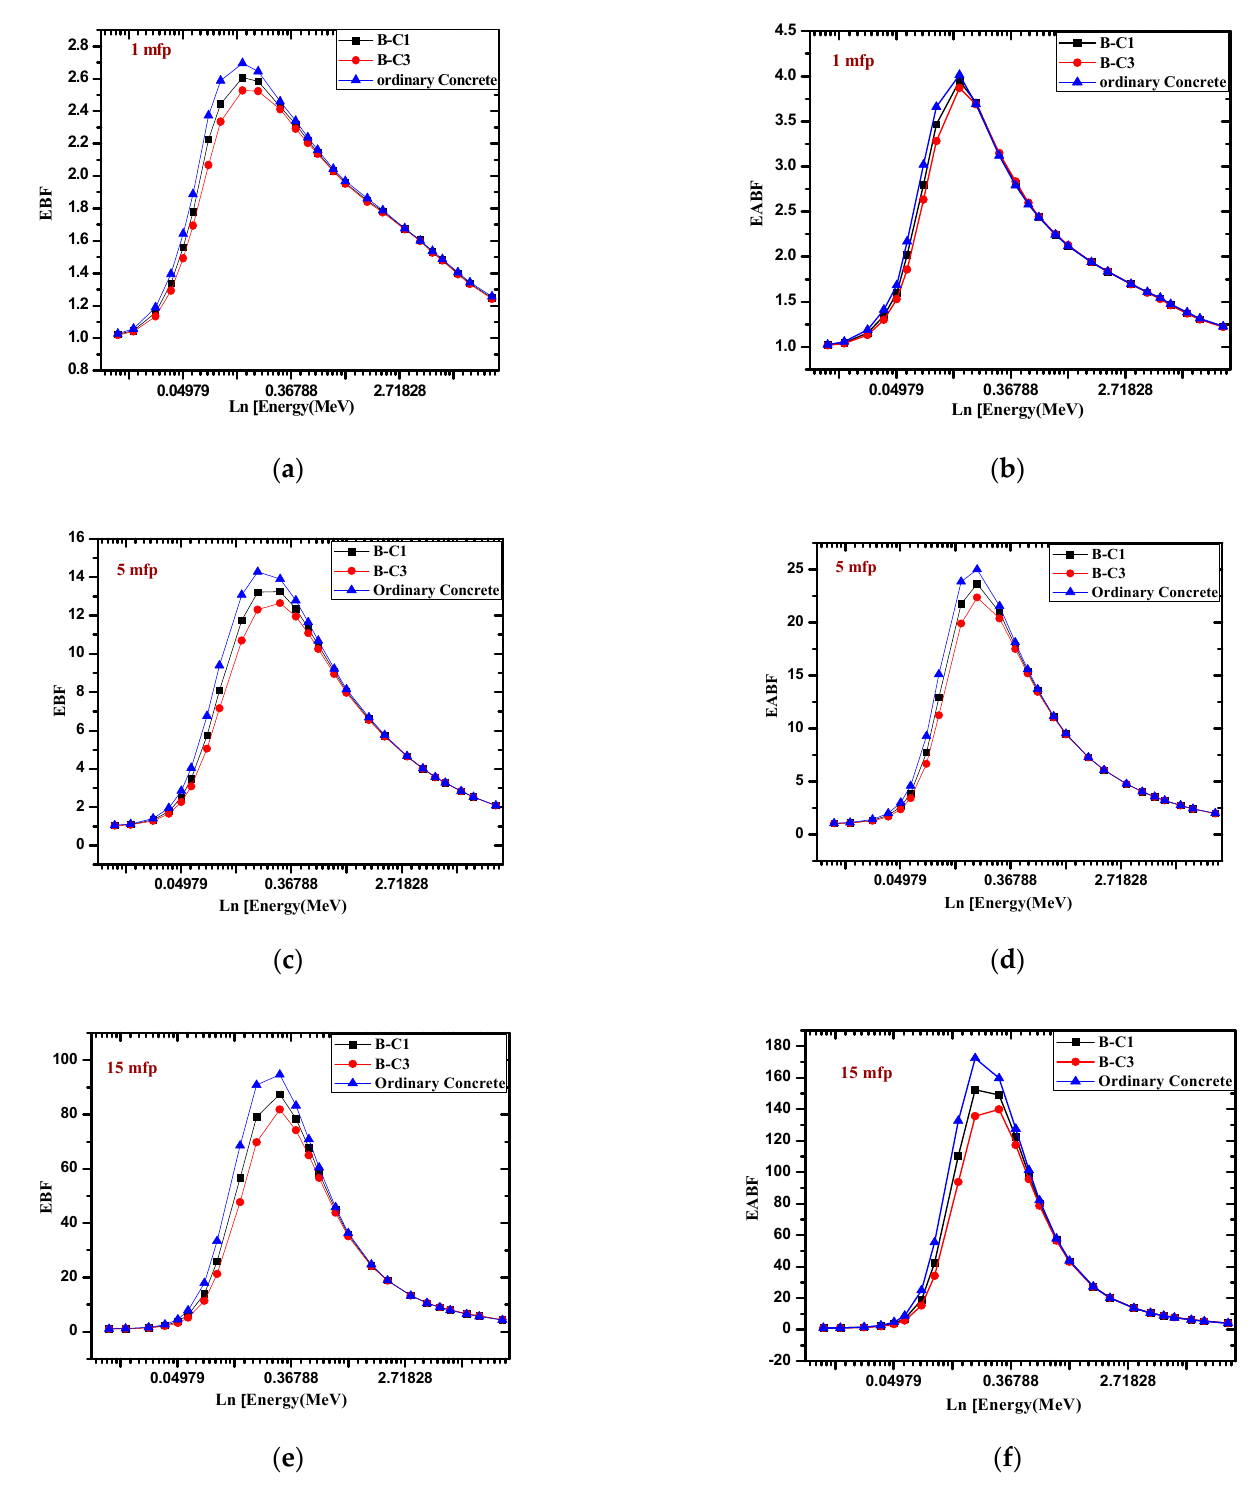
Figure 6. The EBF and EABF variation against different energy in log scale of the present samples compared with concrete at 1 mfp, 5 mfp and 15 mfp. ( a ): EPF at 1 mfp; ( b ): EAPF at 1mfp; ( c ): EPF at 5 mfp; ( d ) : EAPF at 5 mfp; ( e ): EPF at 15 mfp; ( f ): EAPF at 15 mfp.